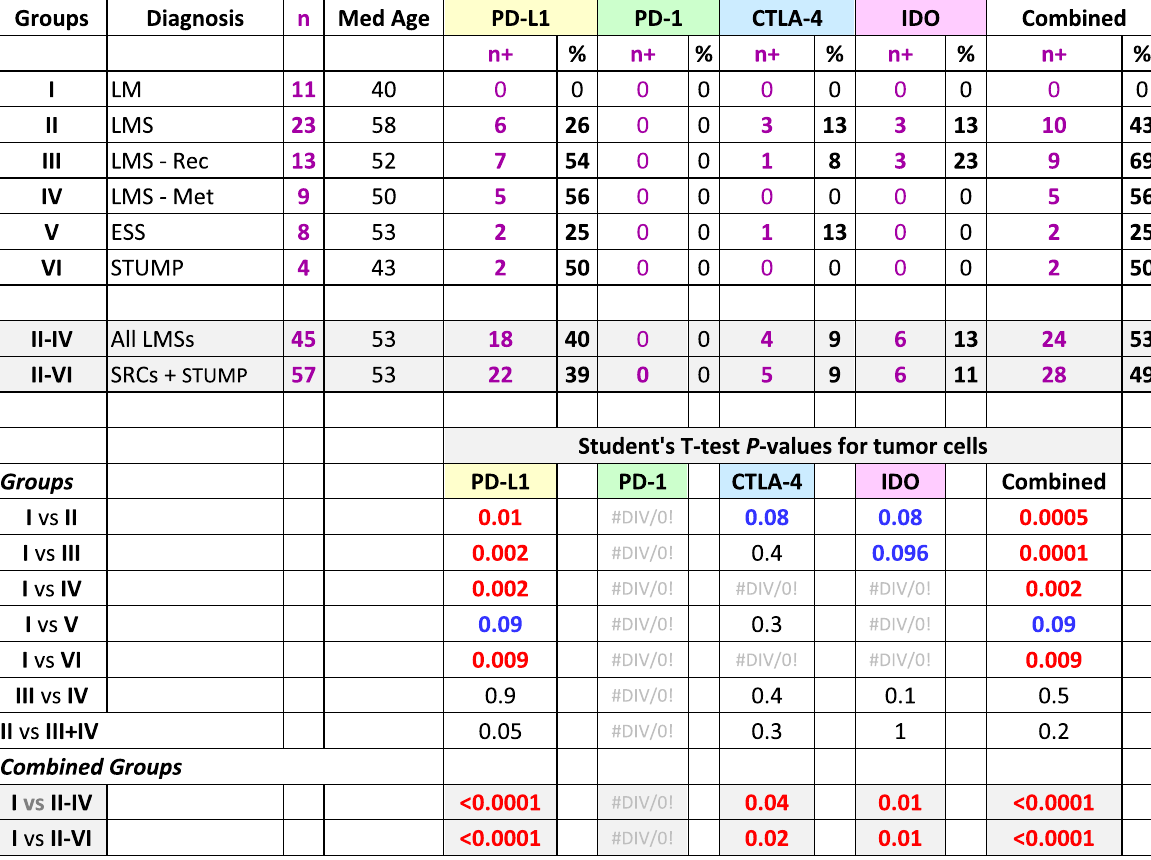
Table 1 Summary of the results of immunohistochemical reactions of the immune checkpoints on tumor cells in each of the six groups of the uterine mesenchymal